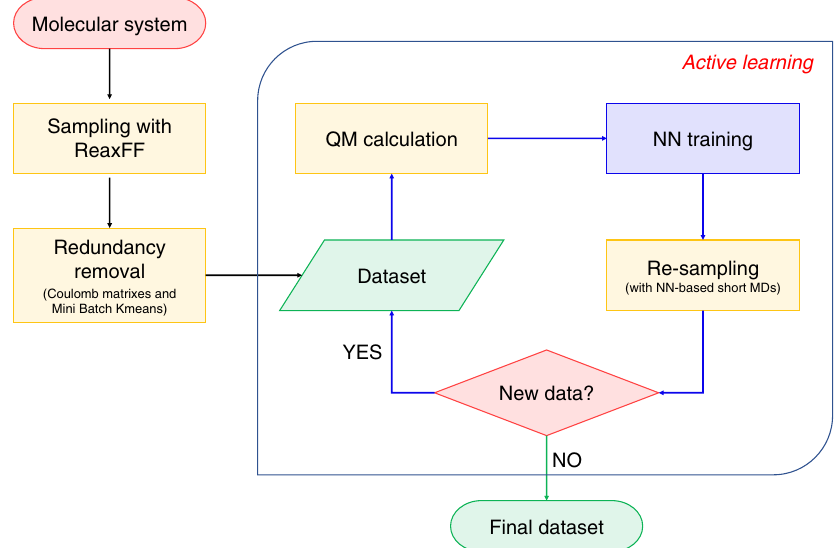
Fig. 5 The work fl ow of reference dataset construction. The process and steps used in this study to generate the reference dataset needed for neural network training to generate the potential energy for MD